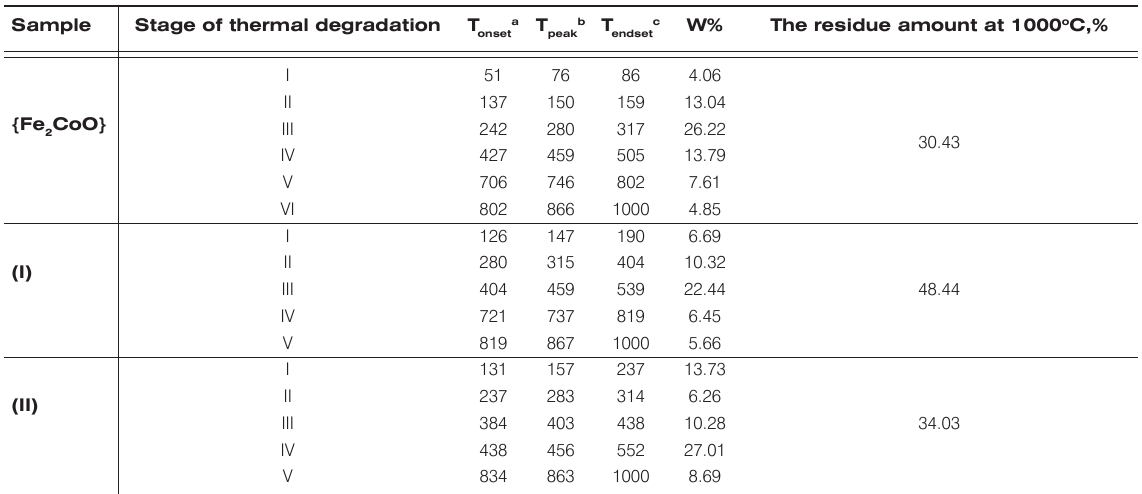
Table 2. The main thermogravimetrical parameters.